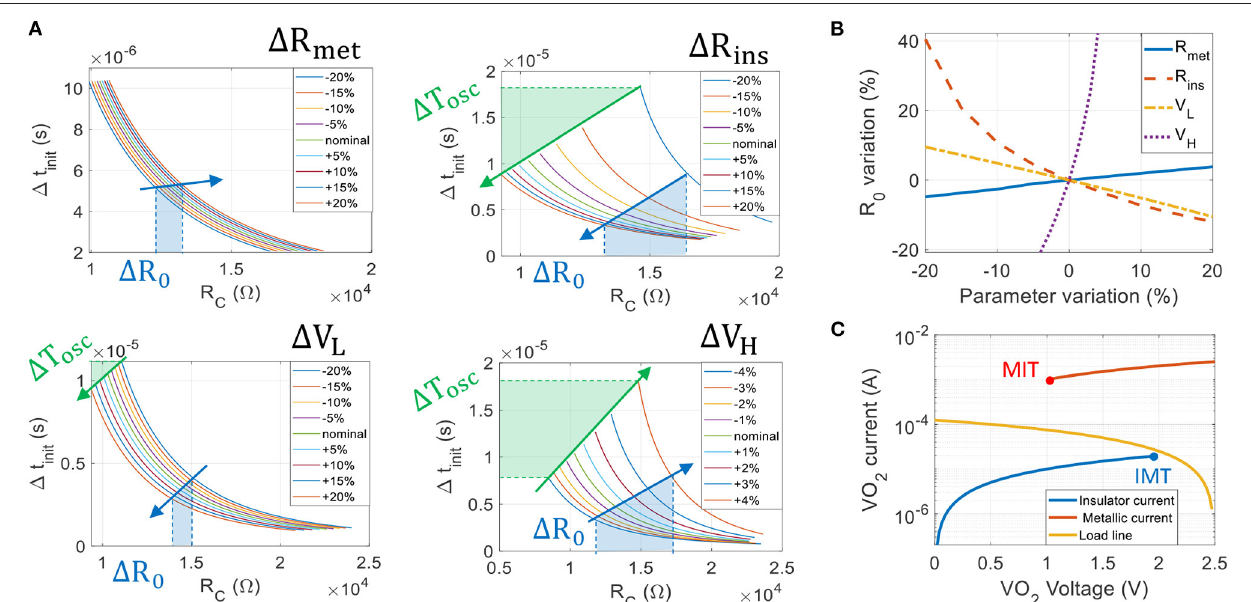
FIGURE 7 | (A) Phase transition curves ζ ( R C ) when varying VO 2 parameters R met , R ins , V L from –20 to +20 % , and V H from –4 to +4 % for circuit parameters listed in Table 1 . Left hand side of the transition curve corresponds to inputs ( 1 t init , R C ) inducing 1φ out = 0 ◦ whereas right hand side corresponds to 1φ out = 180 ◦ phase region. V H and R ins variations correspond to IMT point variations and have the most detrimental impact on the transition function variations. The oscillating period almost doubles due to IMT variations. (B) Variations of the neutral synaptic resistance R 0 with respect to VO 2 parameters’ variations. R 0 is very sensitive to V H as –4 and +4 % V H variations induce –20 and +40 % R 0 variations, respectively. (C) The ONN sensitivity to IMT point is mainly due to the load line I L = ( V DD − V ) / R S placed close to IMT point. Any IMT variation greatly impacts the oscillators’ dynamics defined by C P dV / dt = I L − I .